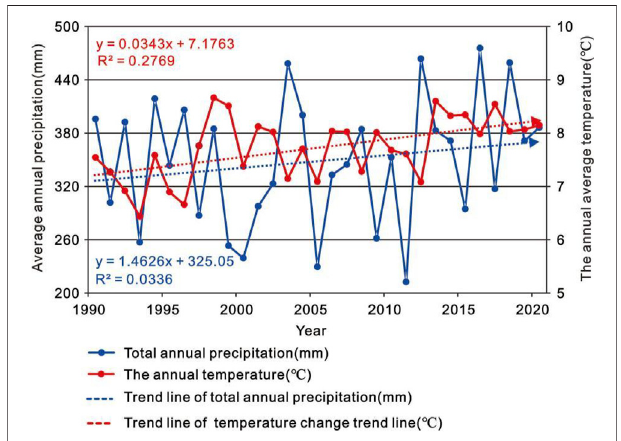
FIGURE 9 | Variation trend of the temperature and precipitation in the Kubuqi Desert area from 1990 to 2020.